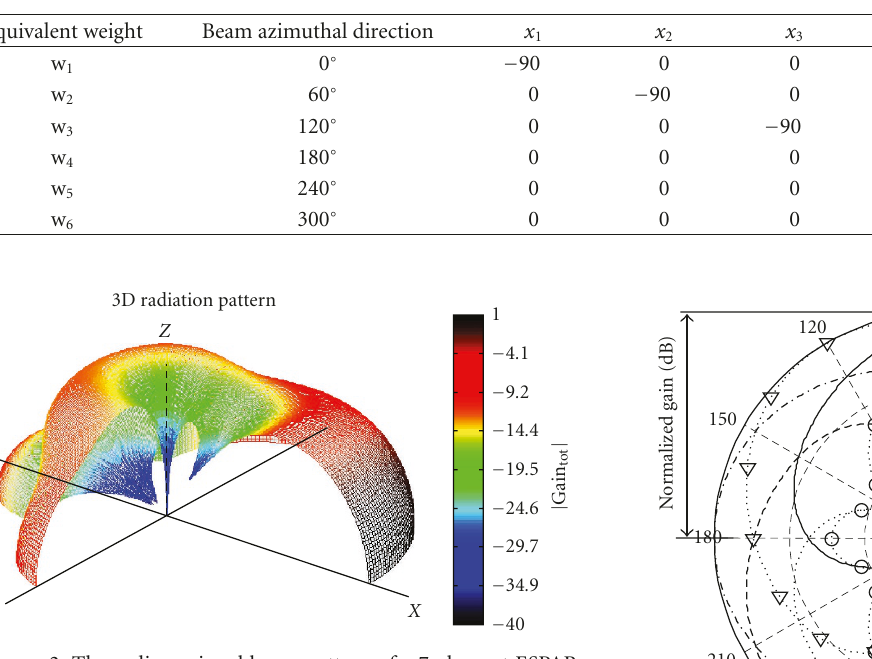
Table 1: Reactance values for di ff erent directional beam patterns.